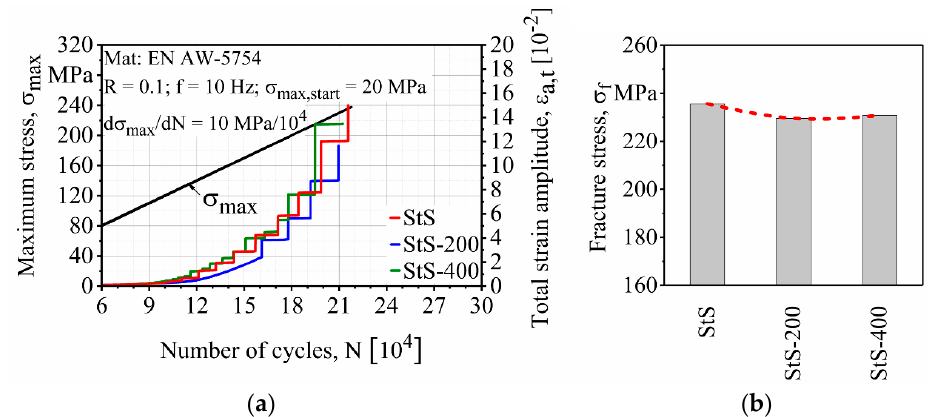
Figure 12. Effect of the surface finishing process on the ( a ) load increase test and ( b ) fracture stresses of stationary shoulder friction stir welded (FSW) specimens.